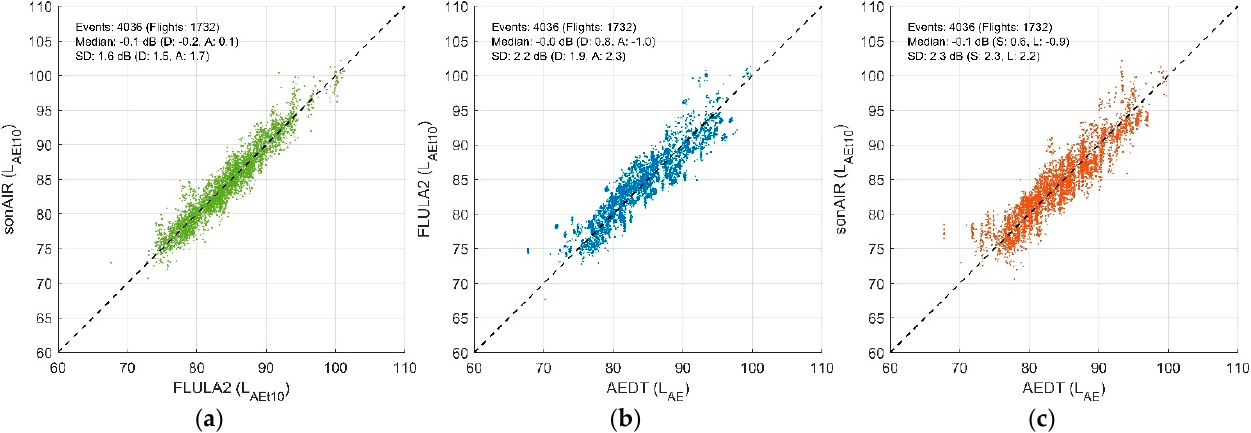
Figure 8. Scatter plots of the calculated event levels L AEt10 (L AE for AEDT) between the three models for aircraft with FDR data in the close range (ZRH and GVA combined), grouped by procedure (D: Departure, A: Approach, SD: Standard deviation). ( a ) sonAIR vs. FLULA2; ( b ) FLULA2 vs. AEDT; ( c ) sonAIR vs. AEDT.